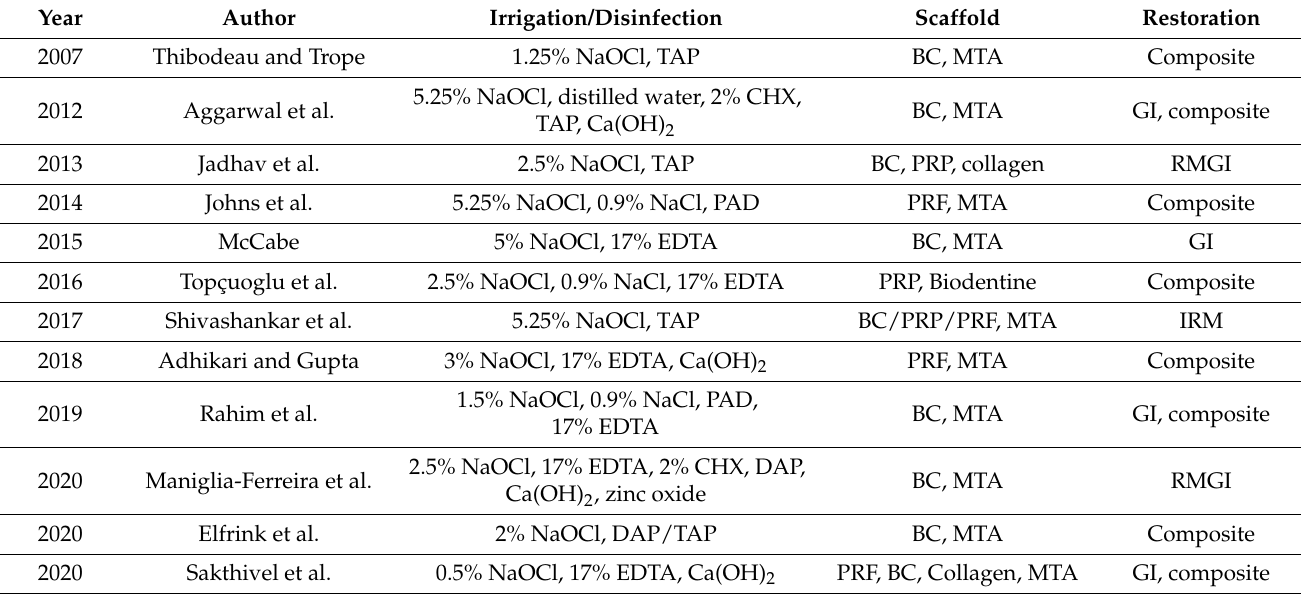
Table 4. Selected REP methods used by different